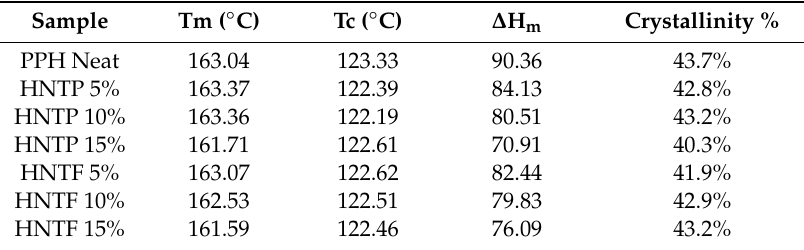
Table 4. Crystallinity index of non-treated fibers/PPH composites.